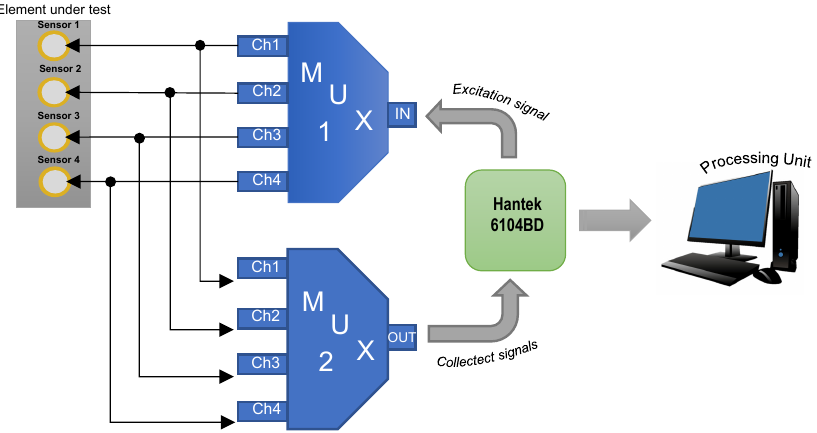
Figure 1. Multiplexing system